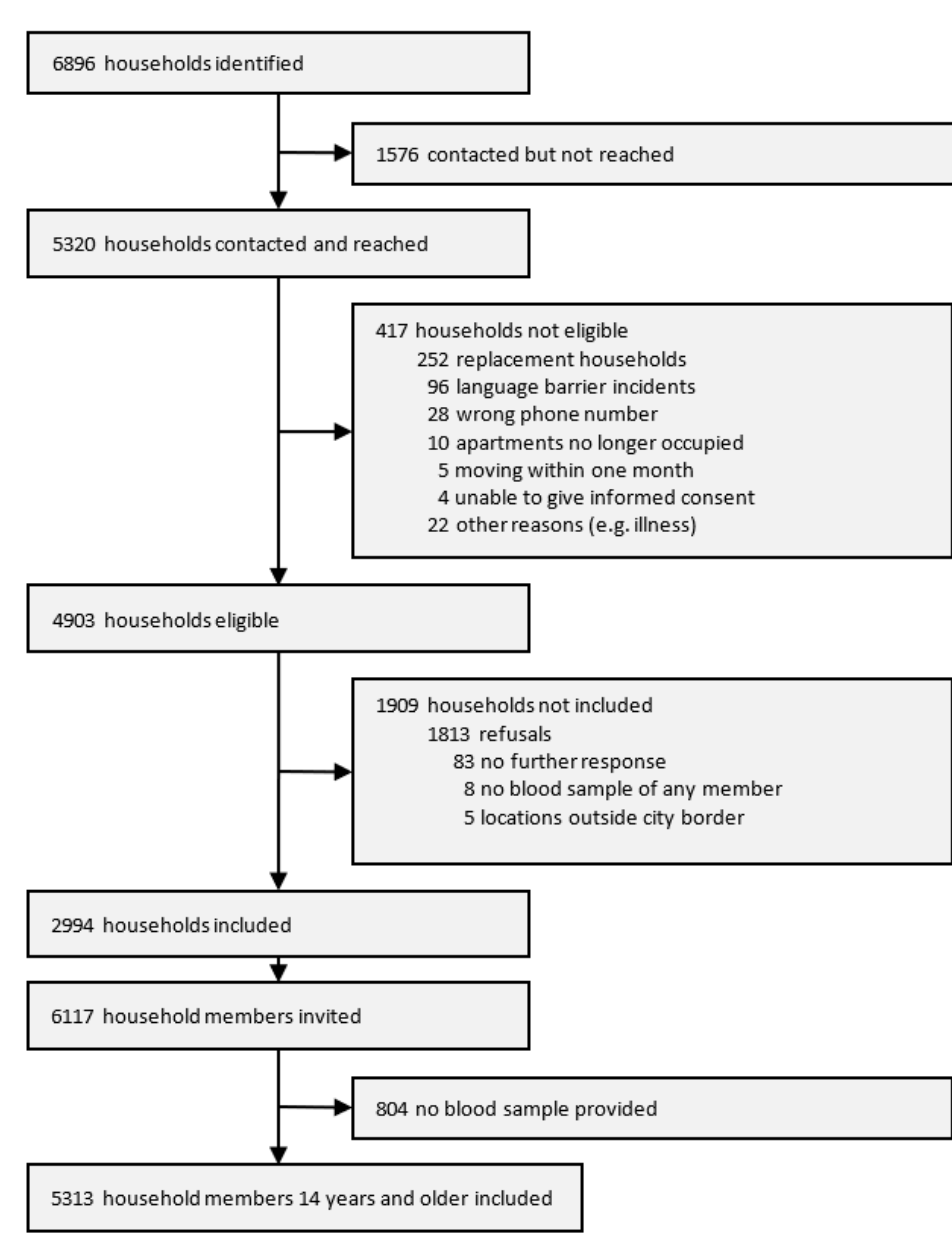
Figure 2. Flow chart on participant selection for the KoCo19 baseline survey.